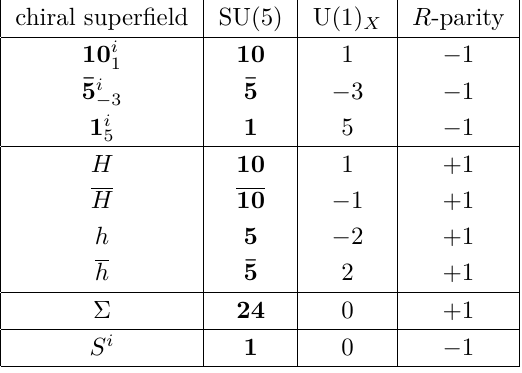
Table 1 . Field content. i labels the three